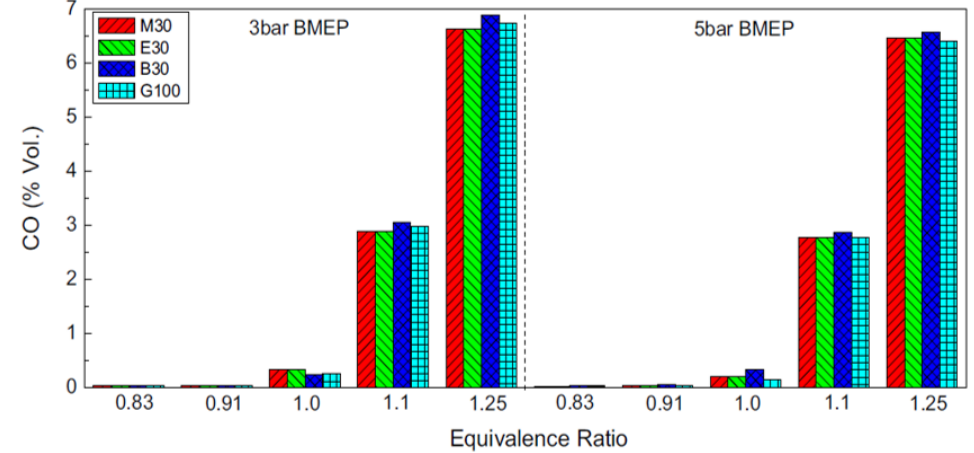
Figure 9. Variation in CO emissions with equivalence ratio, engine load and test fuel: comparison between gasoline (G100), 30% methanol v/v (M30), 30% ethanol v/v (E30) and 30% butanol v/v (B30) [95]. Reproduced with permission from Applied Thermal Engineering; published by Elsevier, 2017. License Number: 5094081168292.